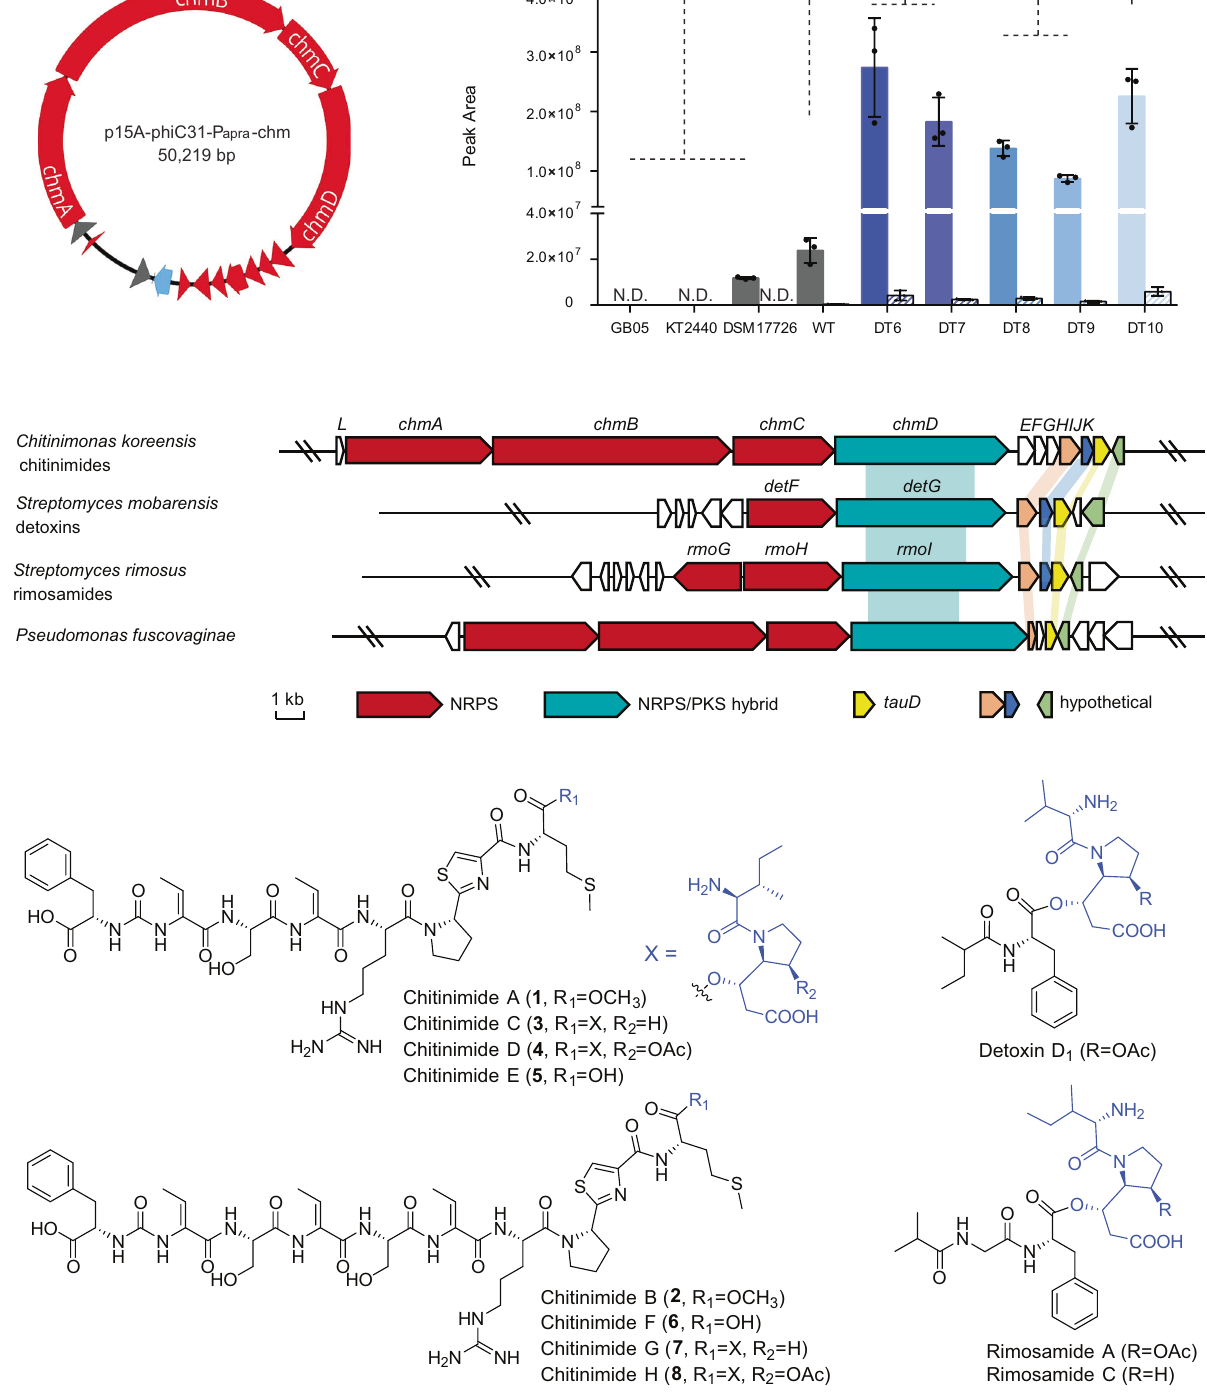
These units were connected to form a linear polypeptide on the basis of the HMBC correlations (Supplementary Fig. 6). In addition, the remaining methoxy group (C-1 ′ , δ H / δ C 3.65, 52.1) and ureido moiety (C-31, δ C 155.6) were located at C-1 and between C-28 and C-33, respectively, evidenced by the HMBC correlations from H-1 ′ to C-1 and from 28/33-NH to C-32.